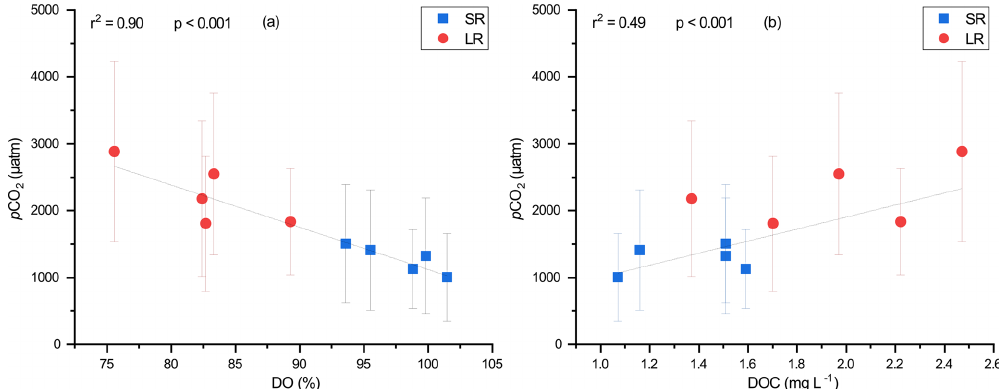
Figure 7. Relationship between seasonal average p CO 2 and (a) DO and (b) DOC. Error bars for the p CO 2 represent 1 standard deviation from the seasonal mean. The DO– p CO 2 and DOC– p CO 2 relationships are shown as solid lines.